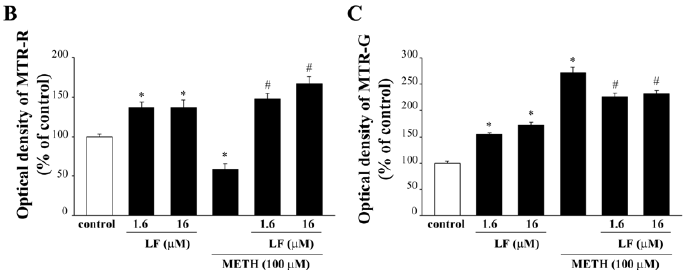
Figure 9. Mito Tracker-fluorescence after combined METH and LF administration. ( A ) Representative pictures of Mito Tracker Red and Mito Tracker Green fluorescent cells, which label healthy and total mitochondria, respectively. Arrows indicate intensely MTR-R or MTR-G-stained cytosolic spots. Optical density of Mito Tracker Red ( B ) and Mito Tracker Green ( C ). MTR-R = Mito Tracker Red; MTR-G = Mito Tracker Green. * p < 0.05 compared with control; # p < 0.05 compared with METH. Scale bar = 13 µ M.